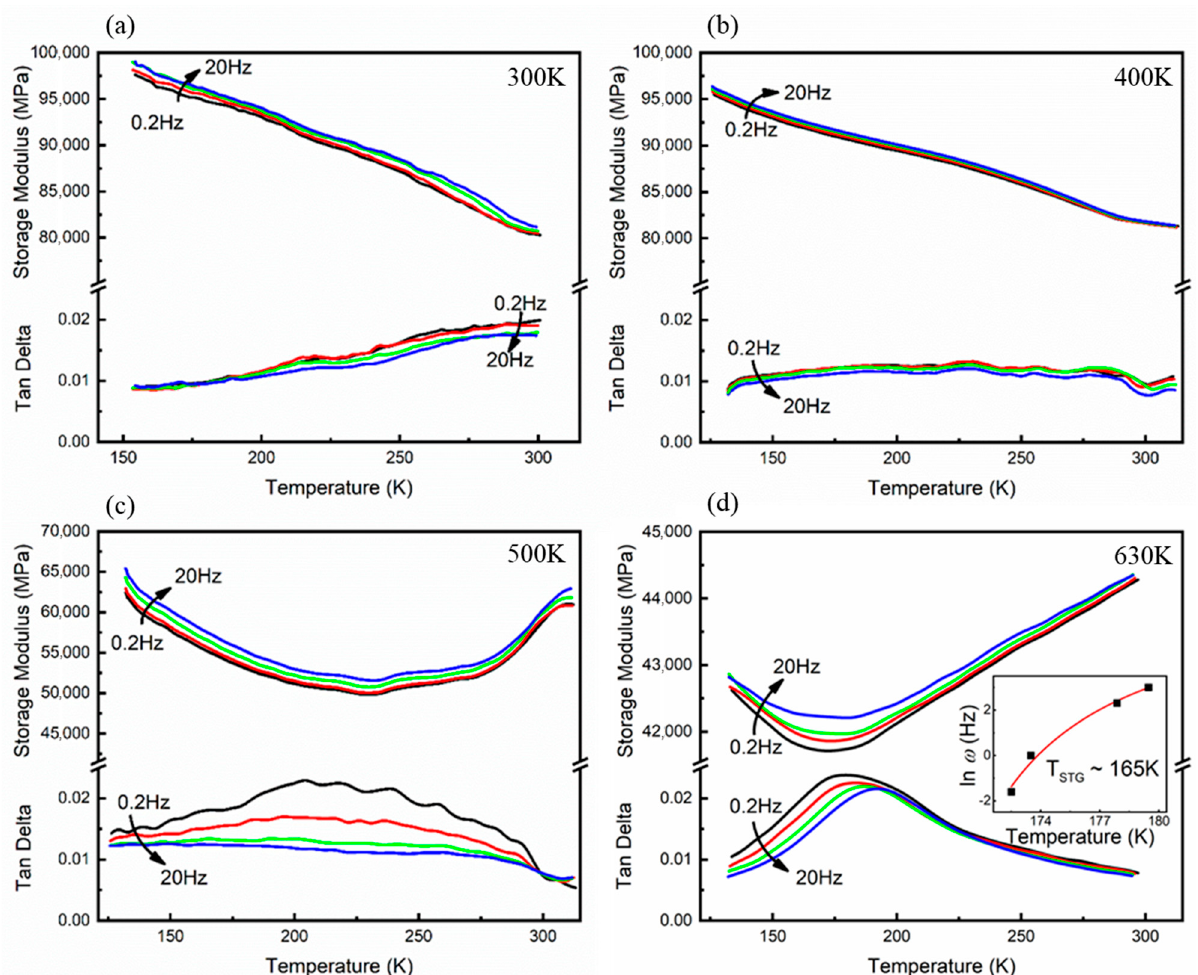
Figure 3. Elastic moduli (Storage Modulus) and internal friction (Tan Delta) curves of the specimens after ( a ) 90% cold rolling and then heating to ( b ) 400 K, ( c ) 500 K, and ( d ) 630 K for 1 h (the cooling rate is 2 K/min at AC field frequency 0.2 Hz, 1 Hz, 10 Hz and 20 Hz).